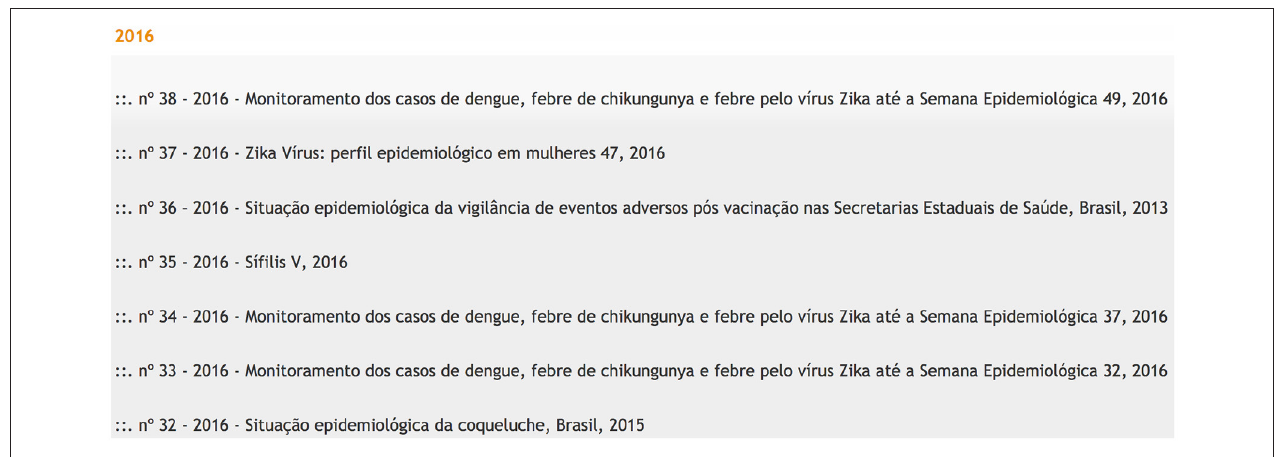
FIGURE 1 | Screenshot showing part of the mosquito-borne illness epidemiological bulletin list available at (31). This is the most current and complete list, with data available through the 38th week of 2016.